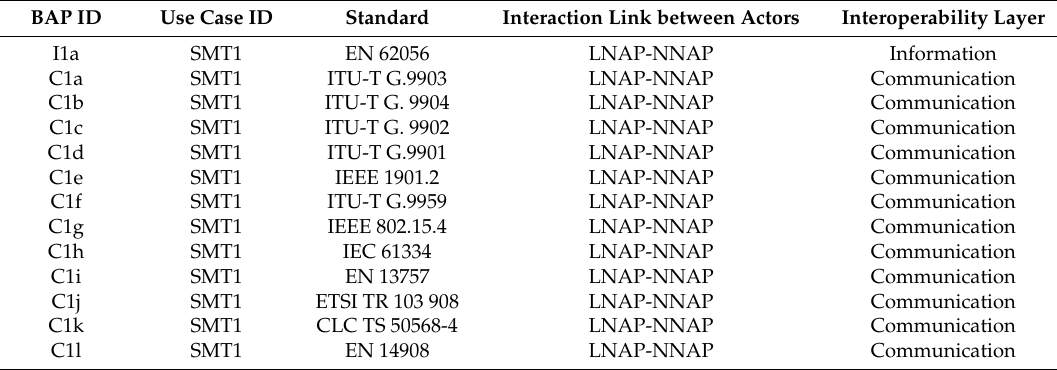
Table 1. Possible Basic Application Profiles (BAPs) for the equipment under test, based on [18].